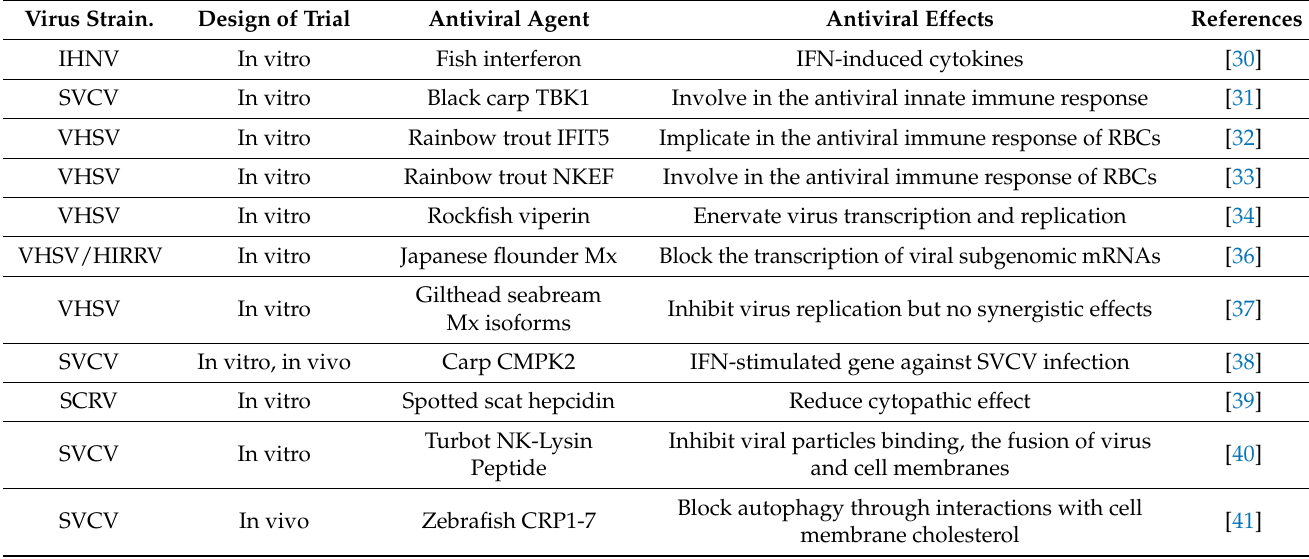
Table 2. Antiviral proteins against fish rhabdoviruses and their antiviral effects. Virus